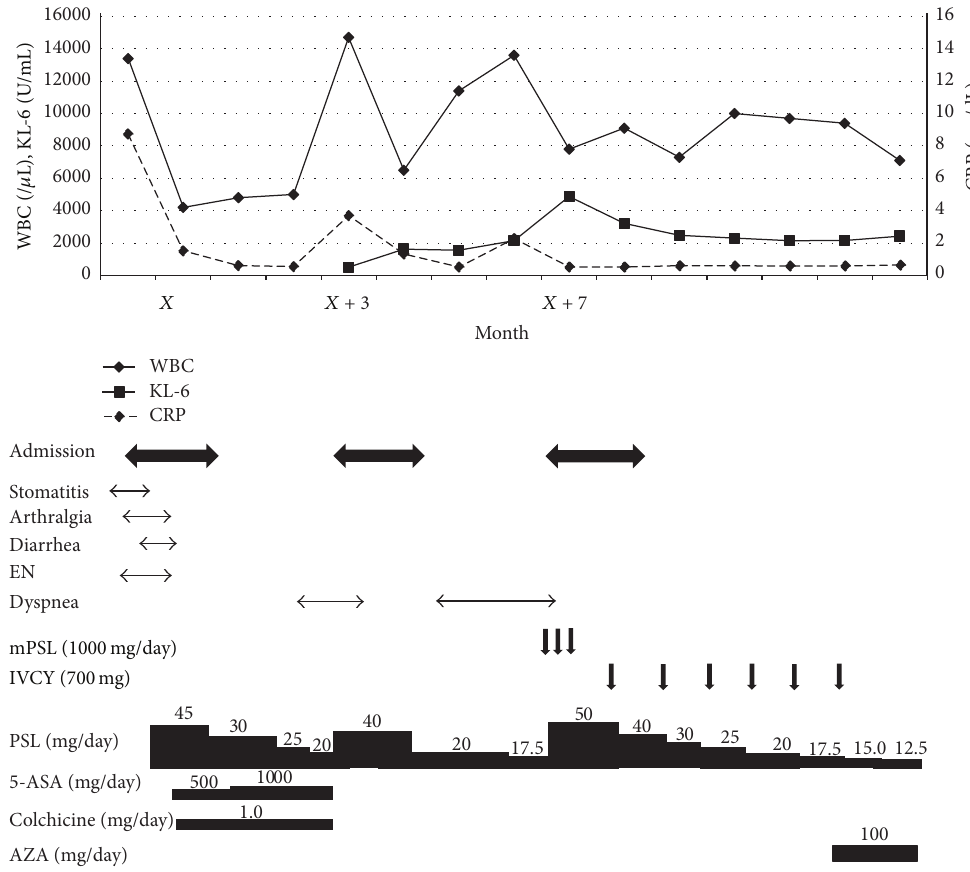
Figure 5: Clinical course of the patient. mPSL: methylprednisolone; IVCY: intravenous cyclophosphamide; 5-ASA: mesalazine; AZA: azathioprine; EN: erythema